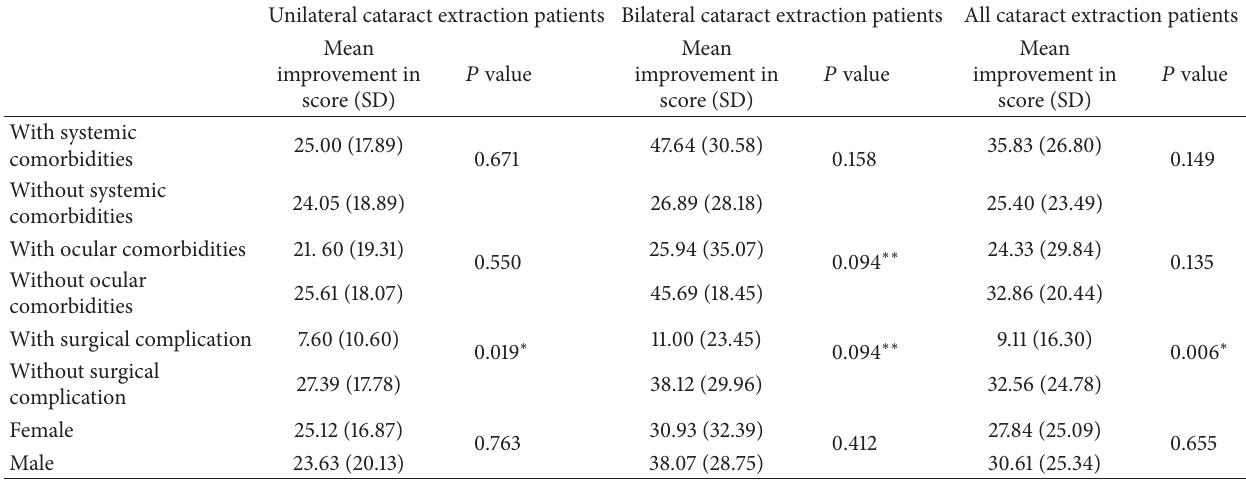
Table 4: Effects of systemic comorbidities, ocular comorbidities, surgical complications, and gender on the improvement of VRQOL score at the end of follow-up period ( ∗ 𝑃 < 0.05 , ∗∗ 0.05 < 𝑃 < 0.10